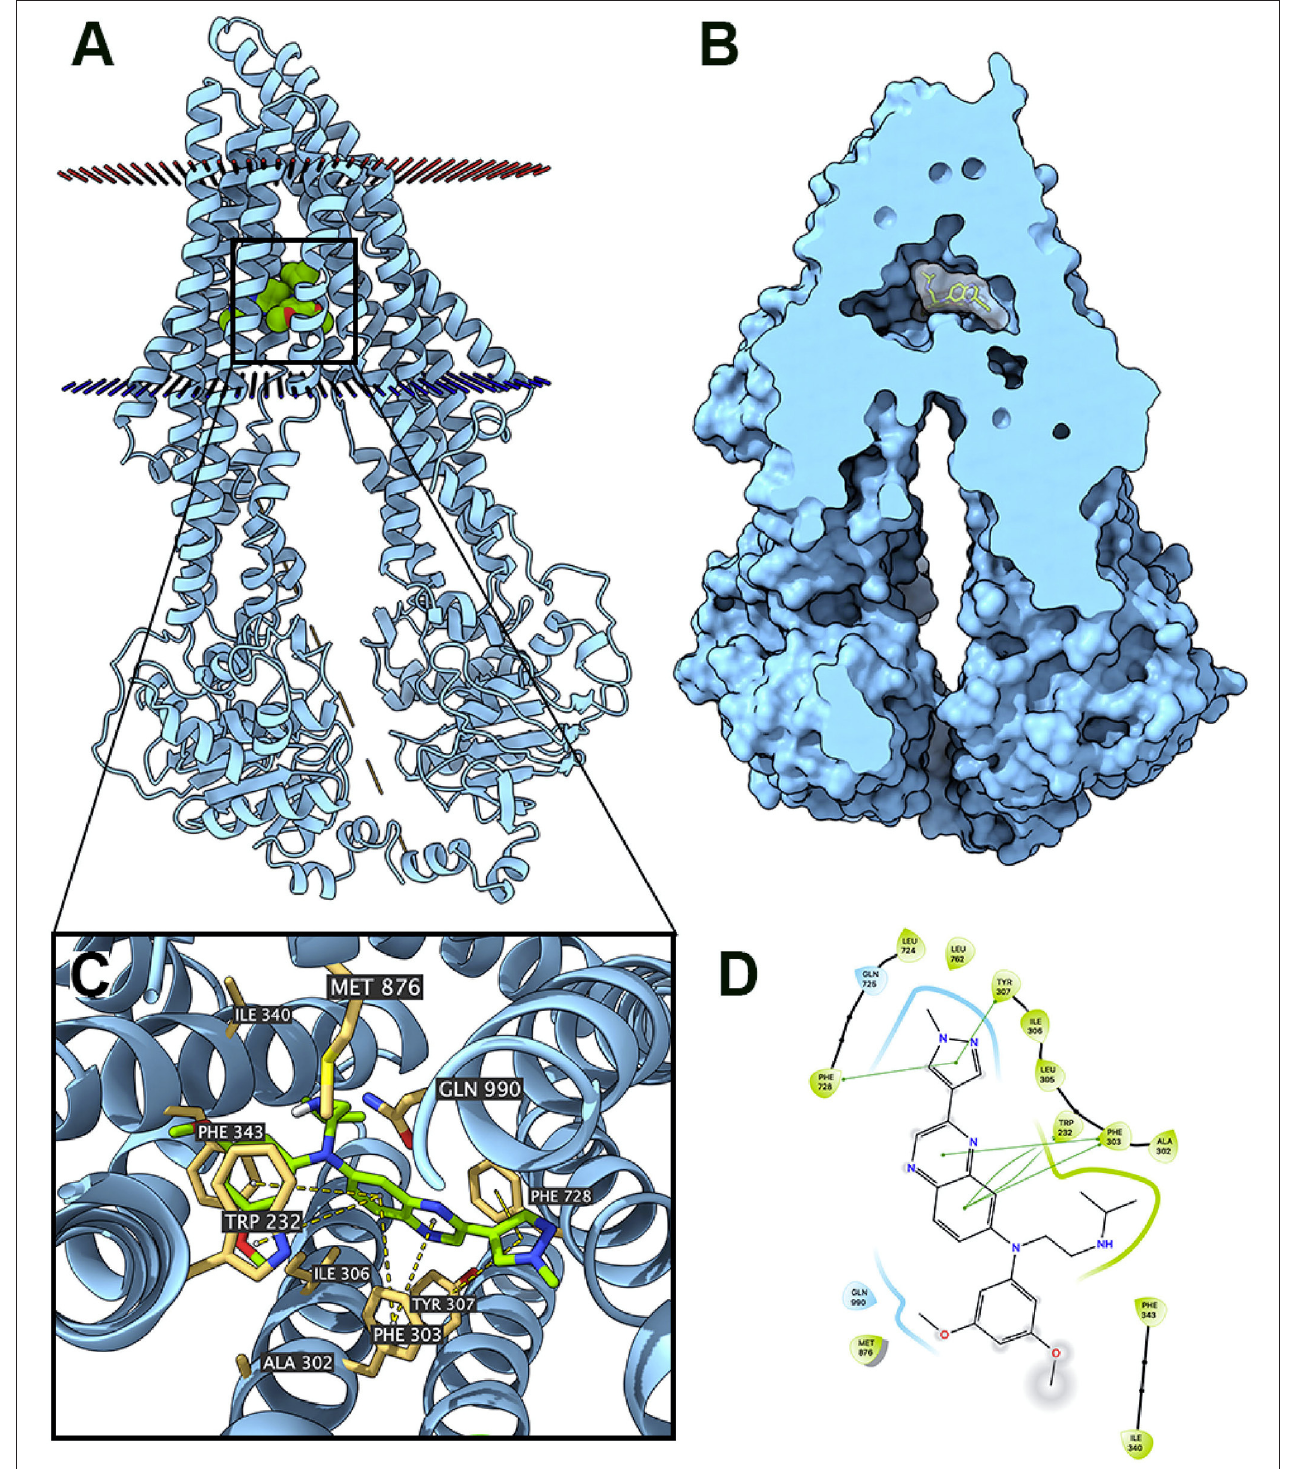
FIGURE 5 | Interaction between erdafitinib and human ABCB1 protein. (A) Overview of the best-scoring pose of erdafitinib in the drug binding pocket of ABCB1 protein. Cytoplasmic membrane was depicted as dotted planes where red or blue plane indicate extracellular or intracellular side, respectively. ABCB1 was displayed as blue ribbons. Erdafitinib was displayed as colored spheres. Green: carbon; red: oxygen; blue: nitrogen. (B) Docked complex displayed with protein surface and ligand surface. Erdafinitib was displayed as colored sticks with white surface. (C) Details of interactions between erdafitinib and ABCB1 binding pocket. ABCB1